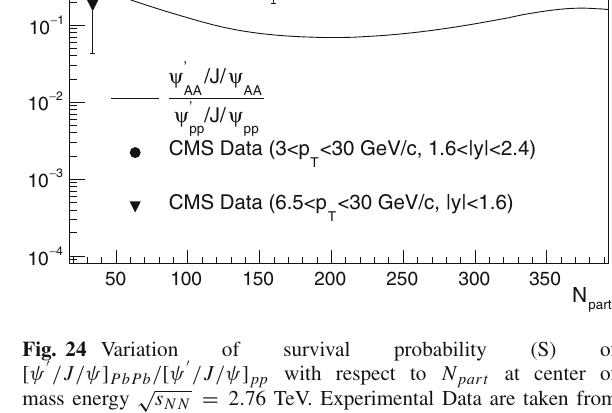
Fig. 22 Variation of survival probability (S) of ϒ( 1 S ) and ϒ( 2 S ) with respect to N part at center of mass energy mental Data are taken from Refs. [55,56]